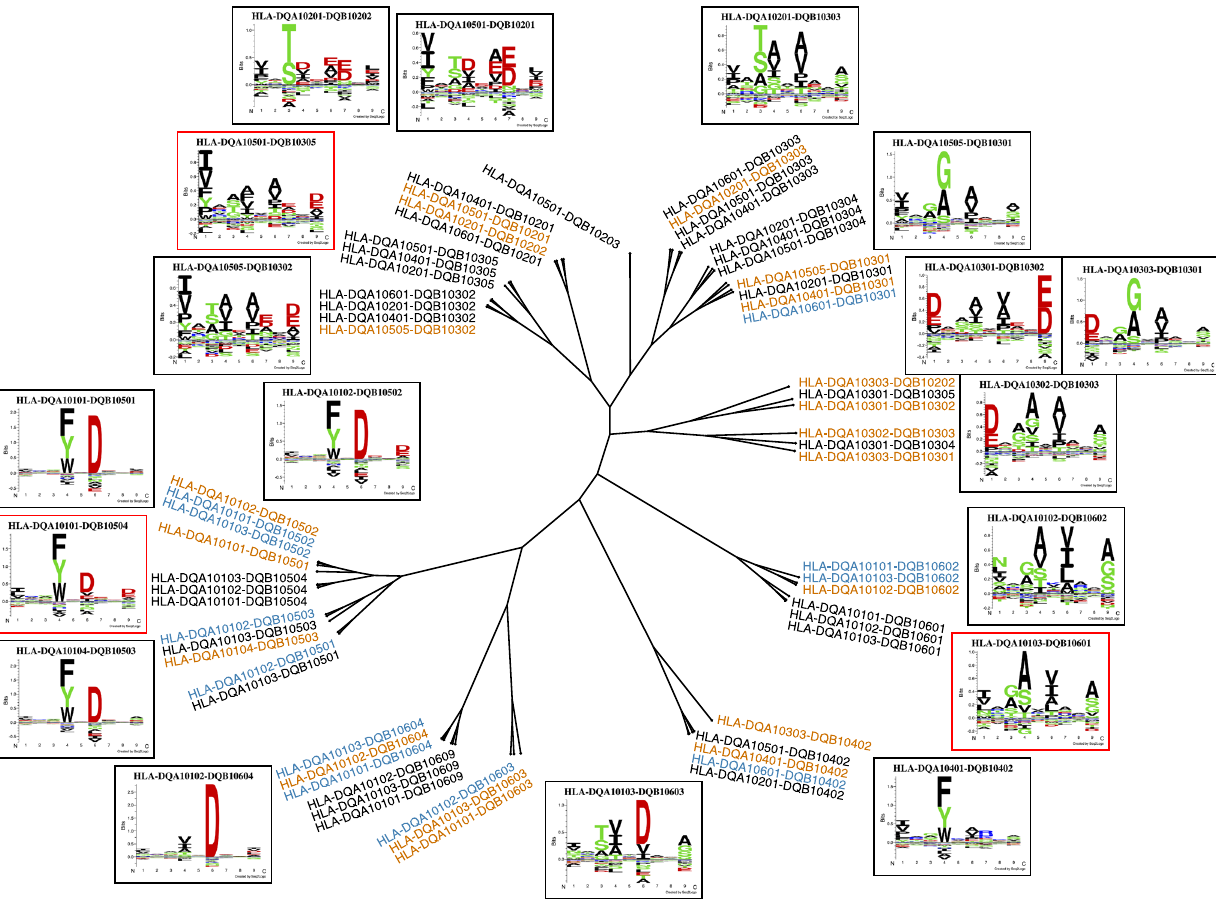
Fig. 5 HLA-DQ speci fi city tree. The tree is based on 61 DQ molecules including the 14 molecules described by the novel data. Orange molecules are covered by the method including the novel data with at least 100 peptides, and blue molecules are within a distance 0.025 of an orange molecule. Black molecules are non-covered (i.e. have peptide count <100 and have distance >0.025 to an orange molecule). Logos in black frames correspond to orange molecules. Logos in red frames correspond to molecules from branches with clusters of non-covered (black) molecules. The speci fi city tree was calculated from the pairwise similarities between the predictions scores for the DQ molecules for a set of 100,000 random natural 13-17mer peptides. Logos were constructed for the top 1% highest scoring binding cores for these 100,000